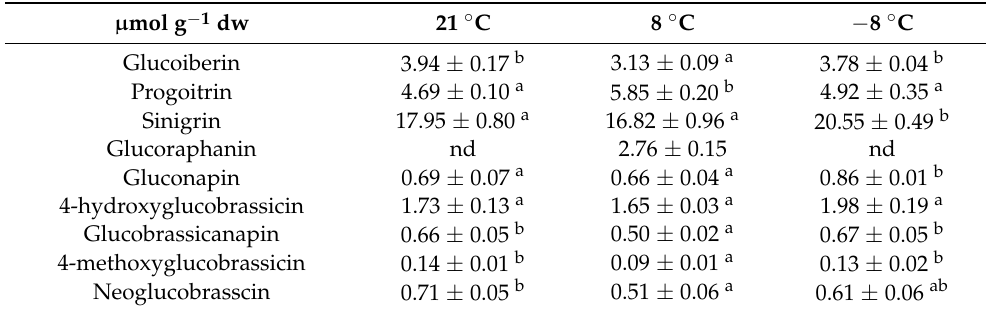
Table 3. Concentration (in µ mol g − 1 dw) of individual glucosinolates in flat leafe kale sprouts ( B. oleracea var. acephala ) affected by different temperatures. Value marked with different letters are significantly different at p < 0.05.